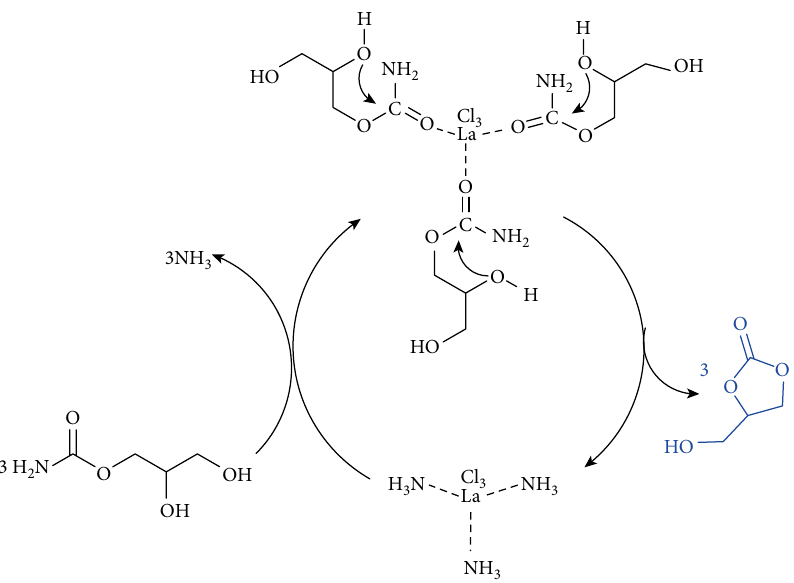
Scheme 11: The proposed reaction mechanism for GC synthesis from HPC over LaCl